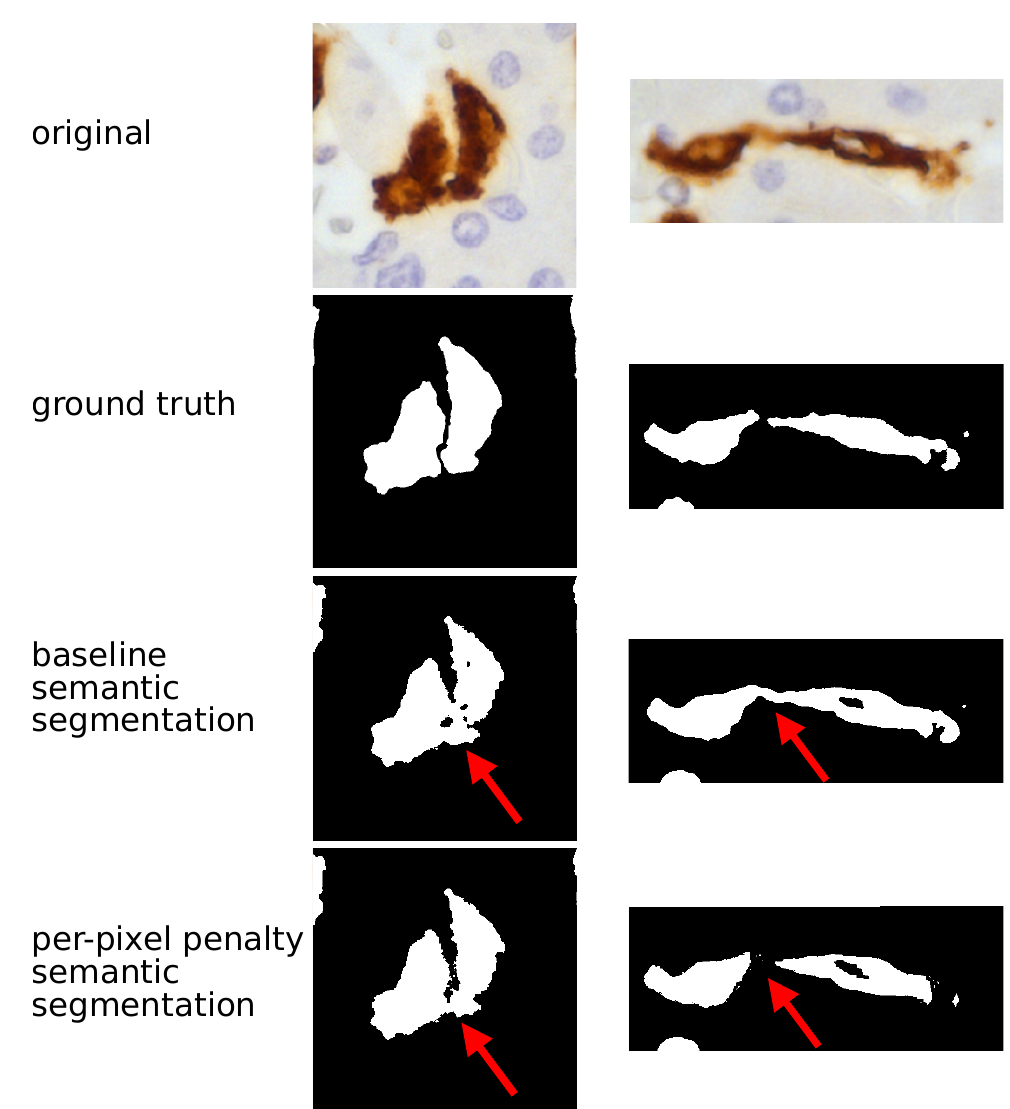
Figure 1. TAM segmentation: semantic approach. The figure compares the histopathological image and the output of CNN model (UNet in these examples) using a semantic approach. In the original image TAMs are stained in brown by CD163 immunostaining and the surrounding hepatocytes (the background) are counterstained in blue; (nuclei darker than cytoplasm); in CNN output TAMs are returned in white and the background in black. The semantic baseline analysis generated an optimal separation between TAMs and the background but was not able to separate adjacent TAMs, as highlighted by red arrows. Adopting the semantic penalty approach fixed part of this specific problem: the two TAMs shown on the right are properly characterized by this